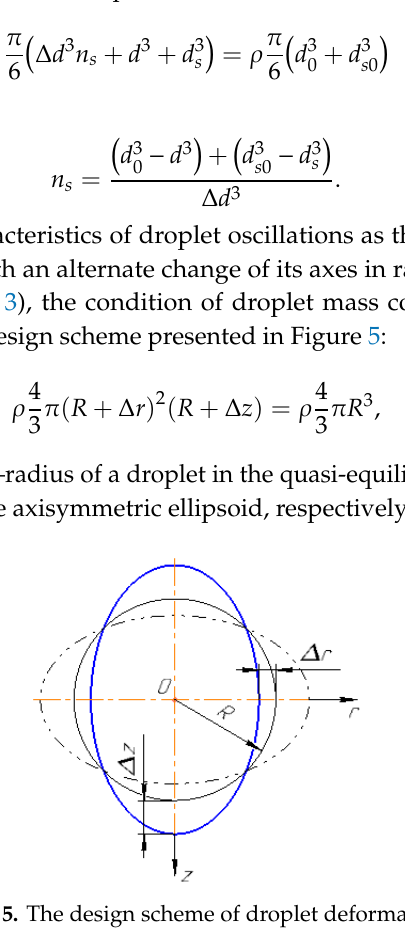
Figure 5. The design scheme of droplet deformations.